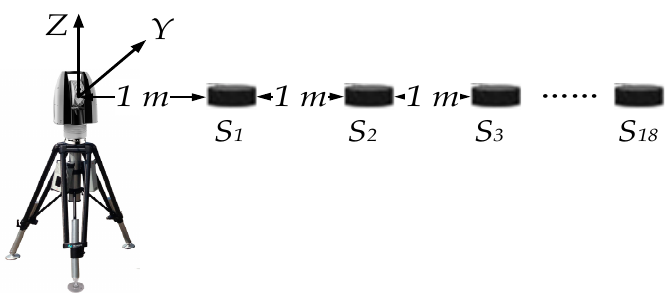
Figure 3. Schematic diagram of distance measurement error calibration.